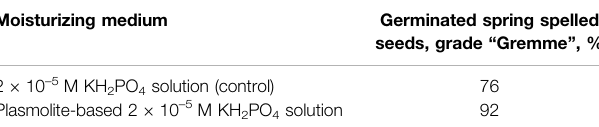
TABLE 1 | Percents of spring spelled seeds, grade “ Gremme ” , that germinated three days after the beginning of seed germination for the two moisturizing mediums tested.